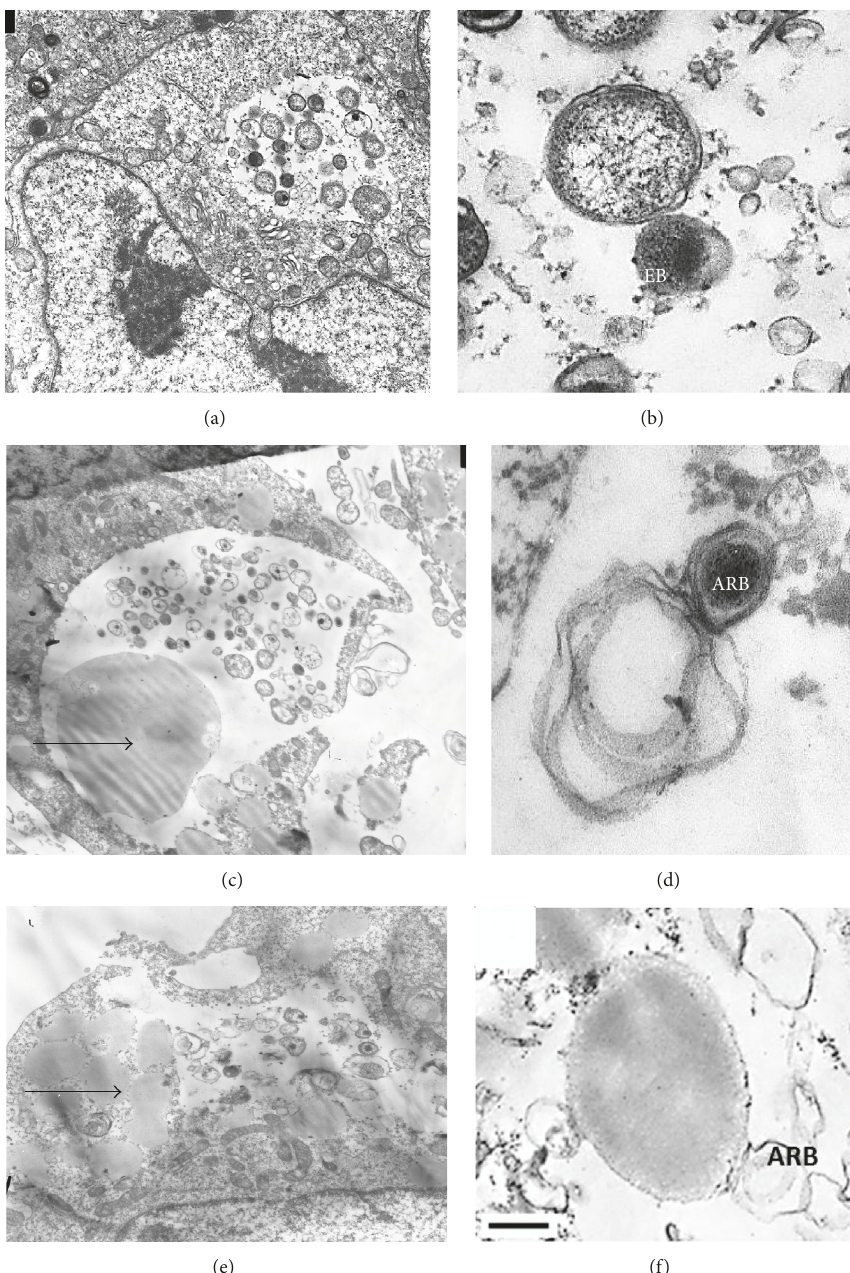
Figure 5: Lycopene treatment disrupts chlamydial developmental cycle in alveolar macrophages B10.MLM. ((a) and (b)) C. trachomatis infection at 42 hpi without lycopene (EB: elementary body and RB: reticulate body); ((c) and (d)) C. trachomatis infection at 42 hpi treated with oil-formulated lycopene (ARB: abnormal reticulate body); ((e) and (f)) C. trachomatis infection at 42 hpi treated with microencapsulated lycopene. Lipid droplets are in close contact to and inside chlamydial inclusions. Arrows indicate lipid droplets. Bar = 0.25 𝜇